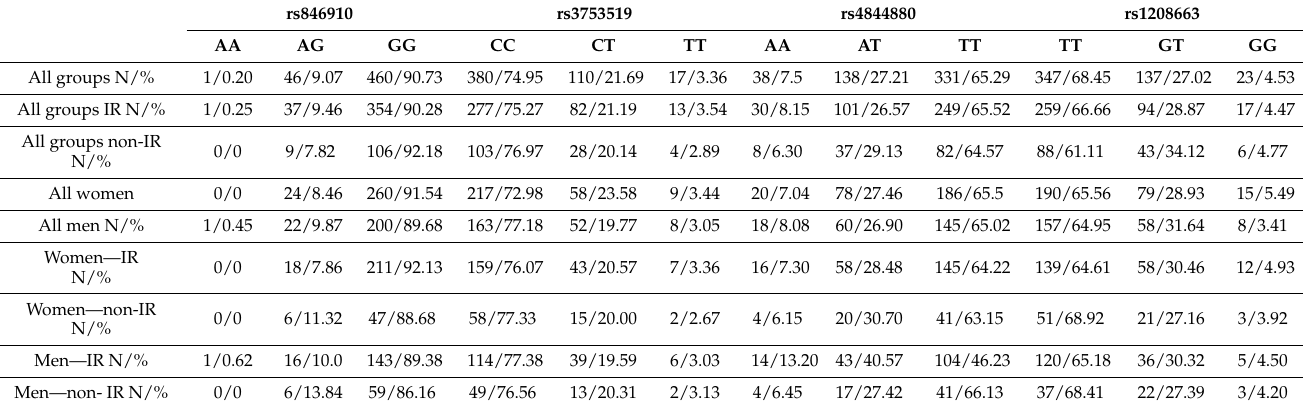
Table 2. The distribution of genotypes tested rs12086634, rs846910, rs4844880, rs3753519 of 11 β -hydroxysteroid dehydroge- nase type 1 ( HSD11B1 ) gene in the entire study group of subjects, in women with and without insulin resistance, and in men with and without insulin resistance.